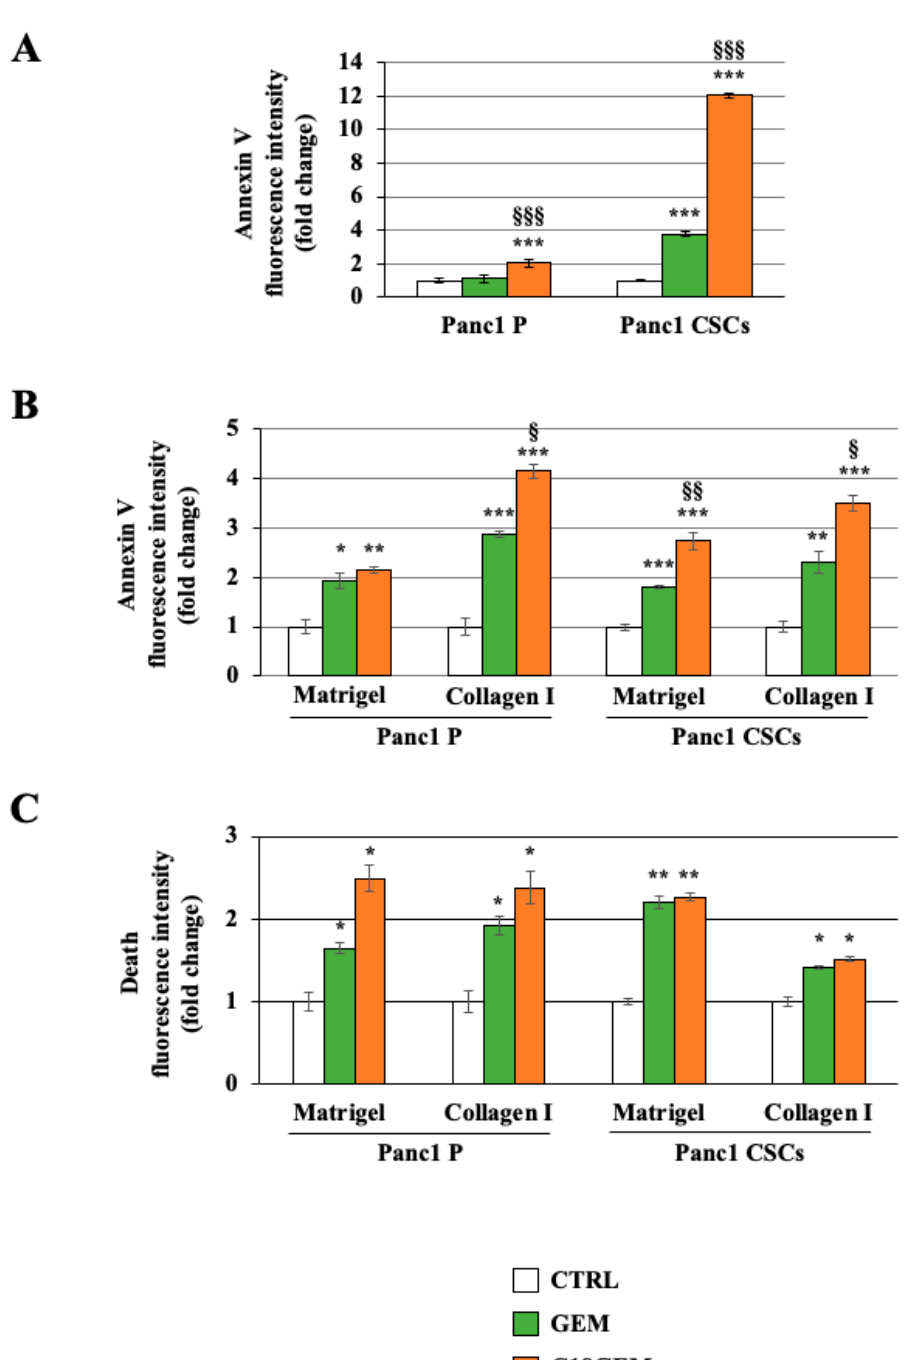
Figure 3. C18GEM induced an increase in regulated cell death compared to GEM in both cell lines grown on 2D or three-dimensional (3D) cultures. Annexin V fluorescence intensity in Panc1 parental (P) cells and CSCs treated with 50 µ M of GEM or C18GEM for 48 h in 2D conditions ( A ) or 72 h in Matrigel- and collagen I-rich ECM, as described in Material and Methods ( B ). Ethidium homodimer fluorescence intensity of P cells and CSCs treated with 50 µ M of GEM or C18GEM for 72 h in Matrigel- and collagen I-rich ECM ( C ). The values are reported as fold change relative to untreated cells and are the means (± SE) of at least three independent biological replicates. Statistical legend: p < 0.05 (*), p < 0.01 (**), or p < 0.001 (***) GEM or C18GEM versus CTRL; p < 0.05 (§), p < 0.01 (§§), or p < 0.001 (§§§) C18GEM versus GEM.